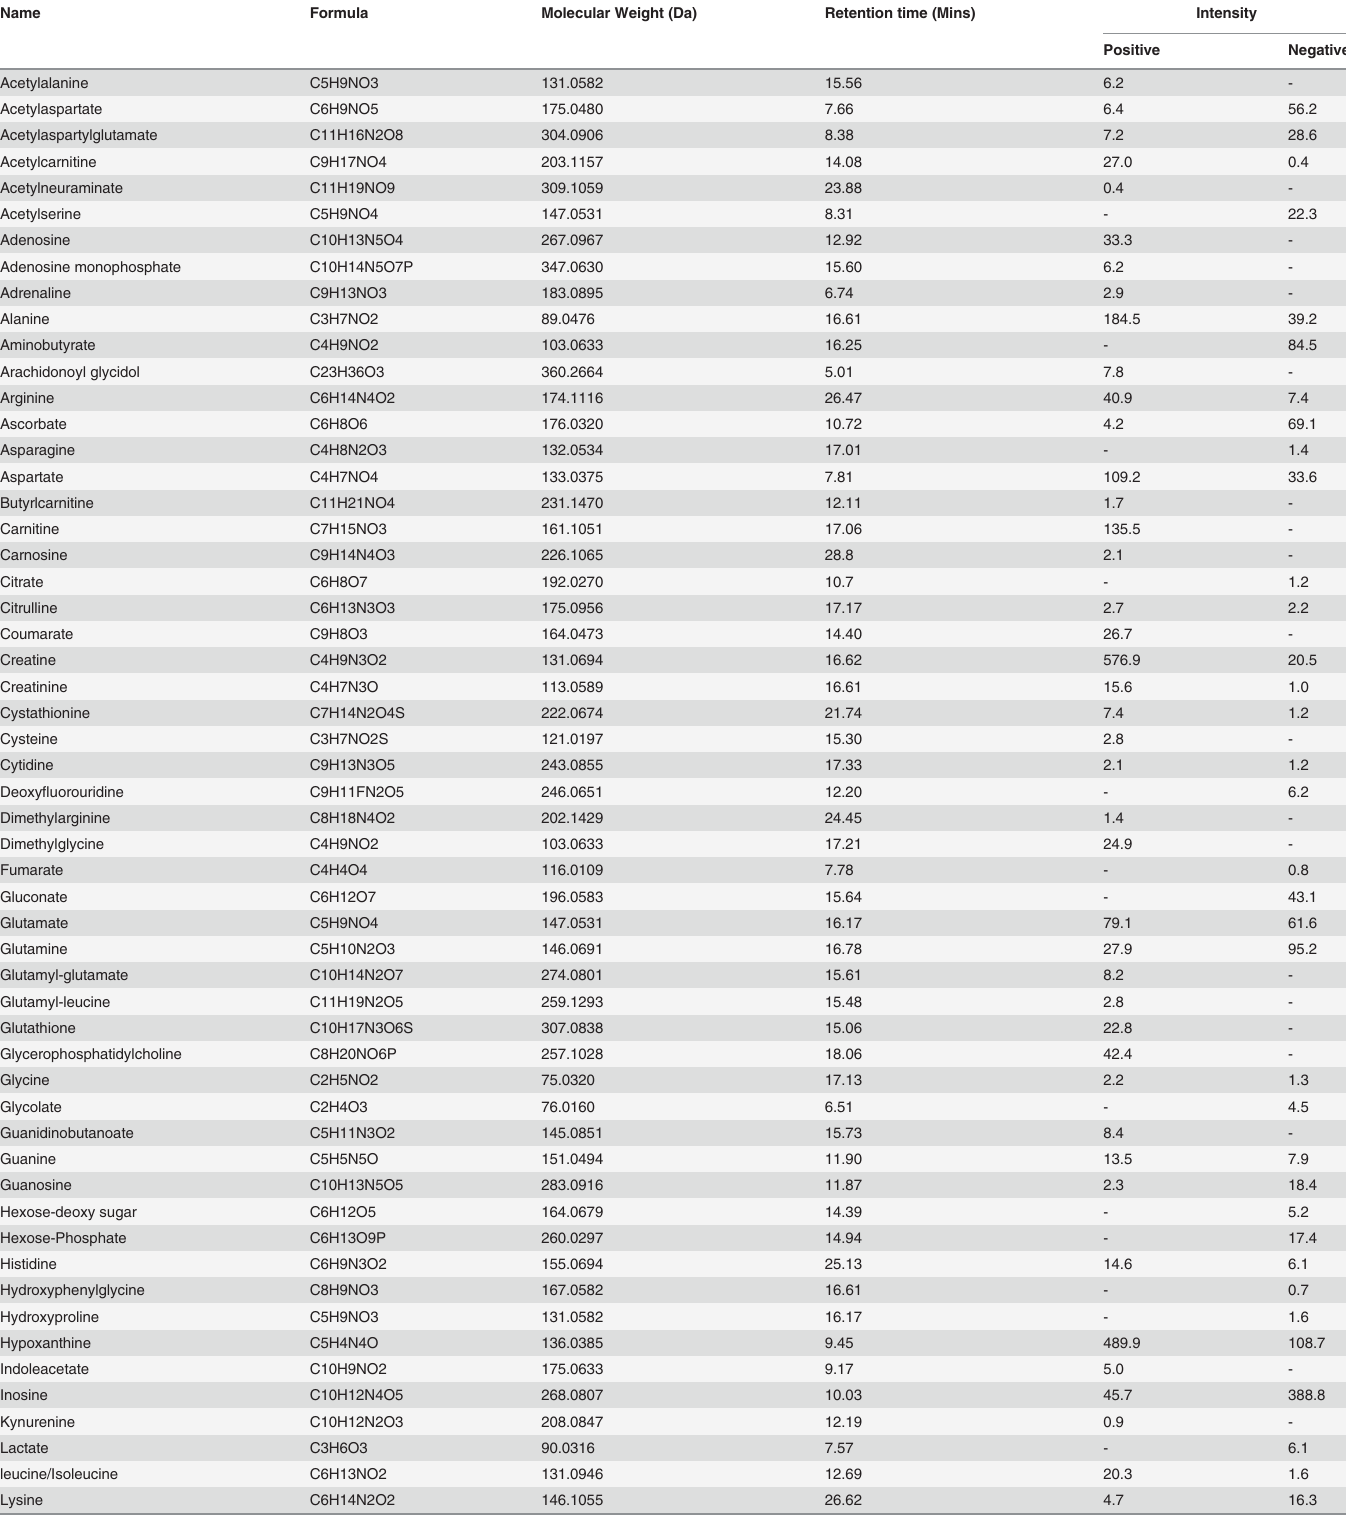
Table 5. Metabolites annotated from the HILIC method.